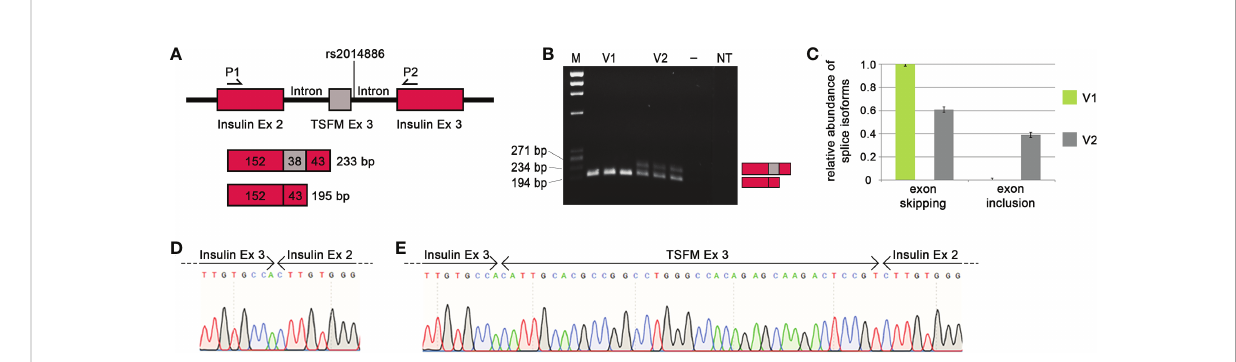
FIGURE 4 Effect of MS-associated splice SNP on TSFM exon 3 skipping. (A) Simpli fi ed depiction of the minigene assay for TSFM . The sequences of TSFM exon 3 (gray box) as well as 400 bp of the up- and downstream introns were cloned between rat insulin exon 2 and 3 (burgundy boxes) of the pDESTsplice vector. The splice SNP rs2014886 is located in the intronic region 2 nucleotides downstream of exon 3. The matching sequences for the PCR primers are located in the sequences of the rat insulin exons (P1 and P2). If TSFM exon 3 is included in the resulting transcript, the PCR product has a size of 233 bp. If exon 3 is skipped, the resulting PCR product has a size of 195 bp. (B) The PCR products for the variants V1 and V2 (from triplicate measurements) were visualized by gel electrophoresis. V1 represents the MS risk allele C and V2 represents the alternative allele T of splice SNP rs2014886. (C) The relative proportions of splice isoforms that resulted due to TSFM exon 3 skipping or TSFM exon 3 inclusion for the allele variants V1 (green) and V2 (gray). The MS risk allele C of splice SNP rs2014886 favors TSFM exon 3 skipping. The two splice isoforms were veri fi ed by reverse direction sequencing (D, E) . — , negative control; bp, base pairs; Ex, exon; M, size standard; MS, multiple sclerosis; NT, non-template control; P1, PCR_RatInsEx2; P2, PCR_RatInsEx3 (Supplementary Table S6, Supplementary fi le); SNP, single- nucleotide